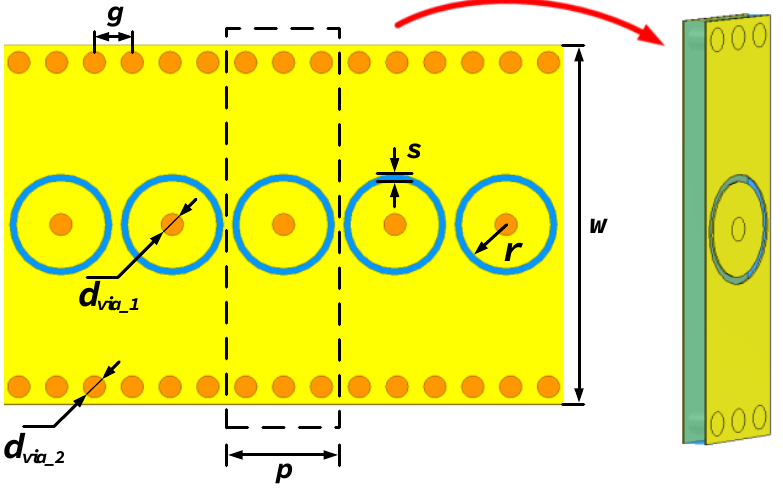
Figure 1. Schematic of the proposed SSPP structure. The dispersion curves of the proposed SSPP structure with different values of parame- ters w , r , and s are shown in Figure 2, where other parameters are maintained constantly. In Figure 2a, as the radius of ring slot r increases, the asymptotic frequency will be decreased, while the lower cutoff frequency remains essentially unchanged. It is indicated that the parameter r mainly affects the cutoff frequency of the SSPP mode and has little effect on the cutoff frequency of the SIW. Additionally, as the SIW width w increases while other parameters are kept unchanged, the lower cutoff frequency will be reduced as shown in Figure 2b. For the variation of parameter s as illustrated in Figure 2c, both of the asymptotic frequency and lower cutoff frequency will be changed, which means that the dispersion of the proposed SSPP waveguide is sensitive to the width of the ring slot. From the above analysis, it is observed that the proposed SSPP waveguide can be easily applied for the design of BPF, and its left and right edges of the passband are mainly determined by the width of SIW walls and radius of the ring slot, respectively. Thus, the bandwidth and center frequency of the proposed SSPP developed from SIW can be easily manipulated by tuning the geometry dimensions of the SSPP unit